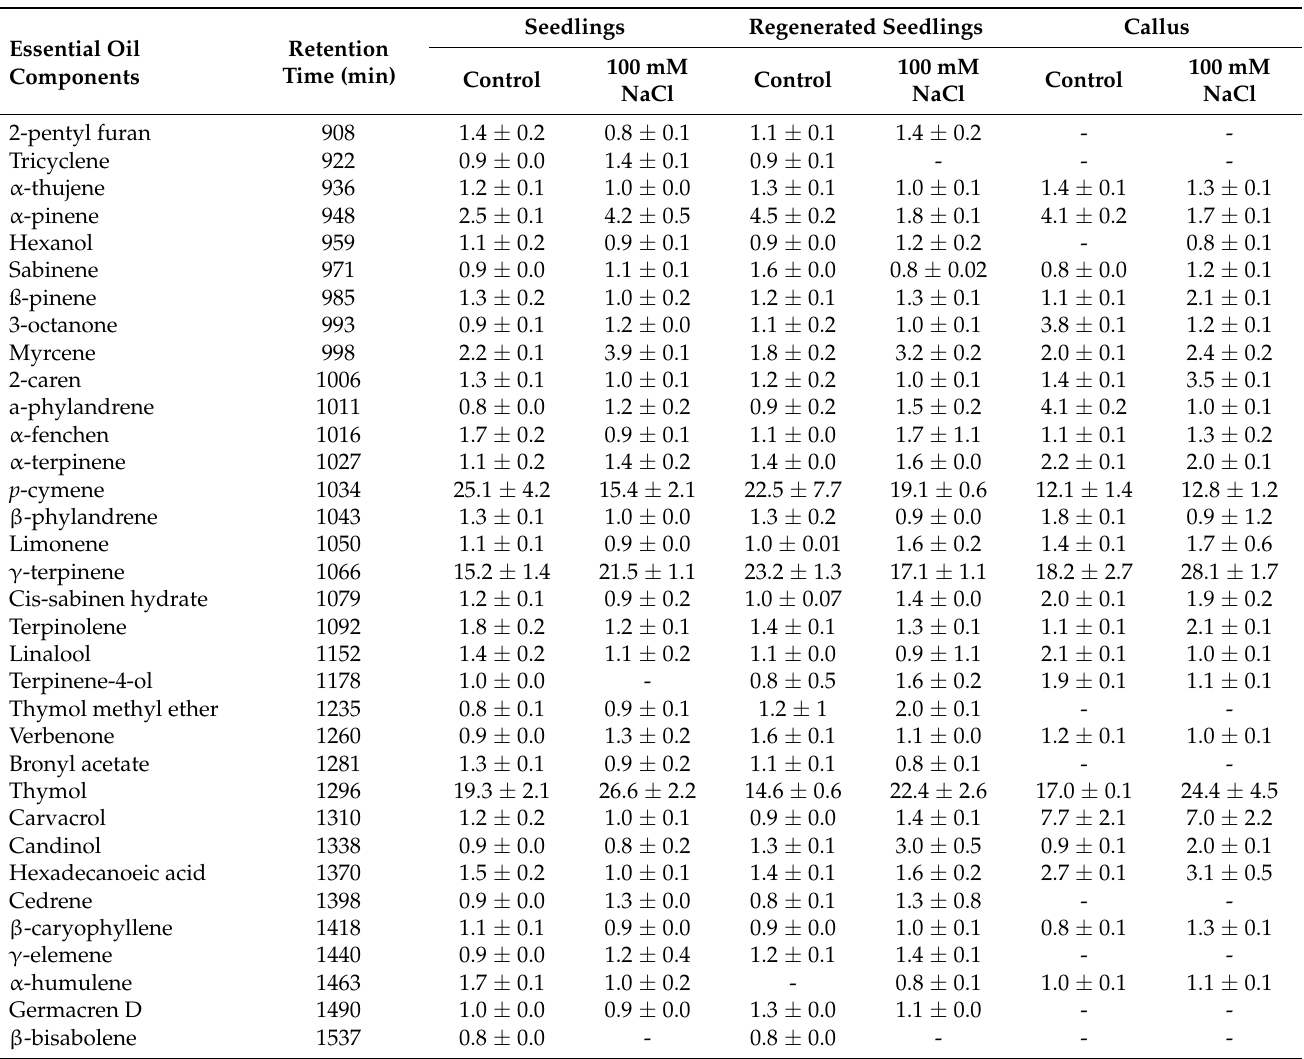
Table 9. Constituents of essential oil of Carum copticum seedlings, calli, and regenerated seedlings were grown with NaCl using